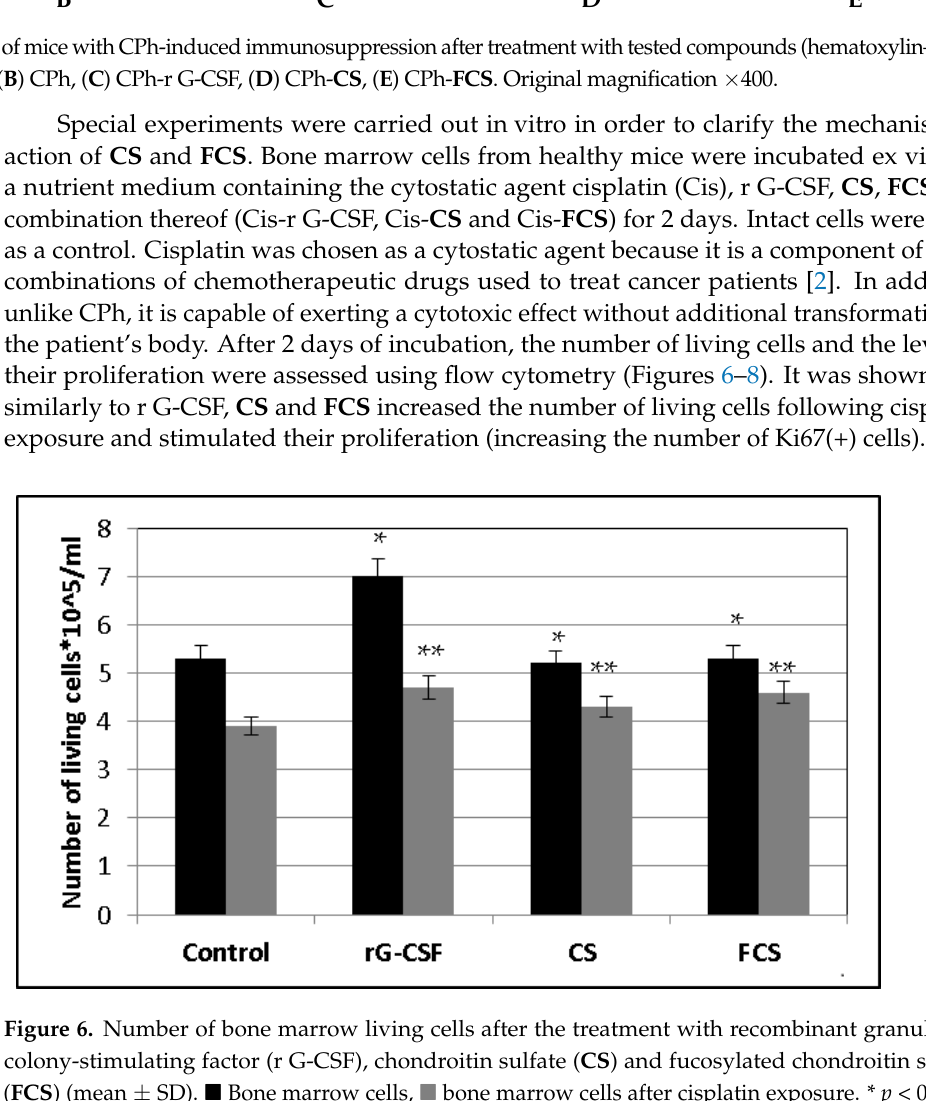
05101520253035 Figure 7. Concentration of Ki67(+) cells (%) after treatment with recombinant granulocyte colony- stimulating factor (r G-CSF), chondroitin sulfate ( CS ) and fucosylated chondroitin sulfate ( FCS ) (mean ± SD, p < 0.05). ■ Bone marrow cells, ■ bone marrow cells after cisplatin exposure. * p < 0.05 vs. control, ** p < 0.05 vs. Cis. The elucidation of the proliferation of the special low numerous population of the hematopoietic cells CD34(+)CD45(+) revealed the same tendency. In the cases of CS and FCS , we observed an increase in the concentration of the proliferating hematopoietic cells [CD34(+)CD45(+)Ki67(+)] by 8 and 5 times, respectively, after cytostatic agent exposure (Figure 8).